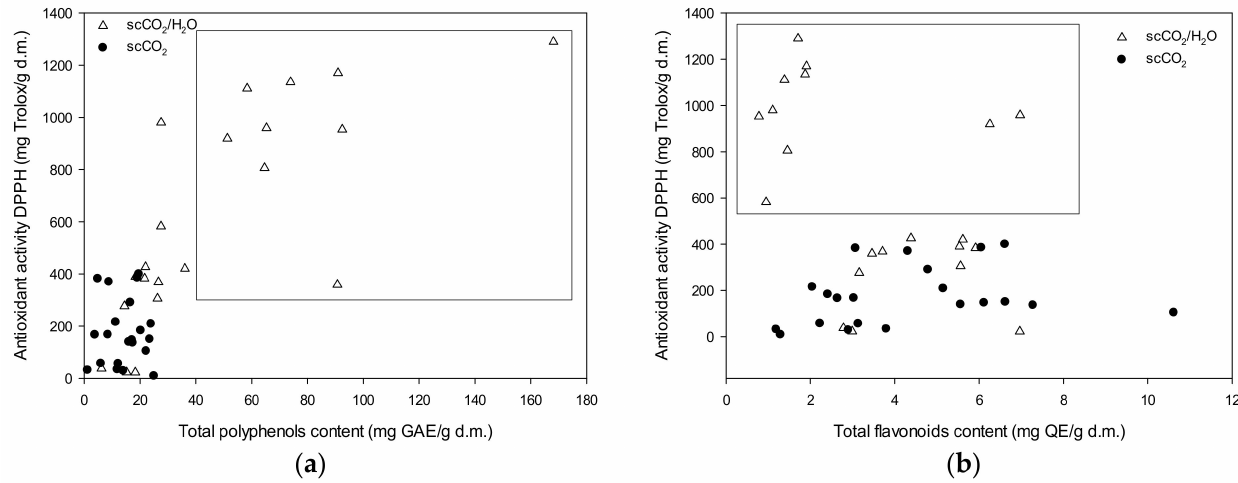
Figure 1. Interaction between ( a ) total polyphenol content (TPC), ( b ) total flavonoid content (TFC) and antioxidant activity determined in scCO 2 /H 2 O ( ∆ ) and scCO 2 ( • ) extracts from perennial herbaceous crops. DPPH - 2,2-diphenyl-1-